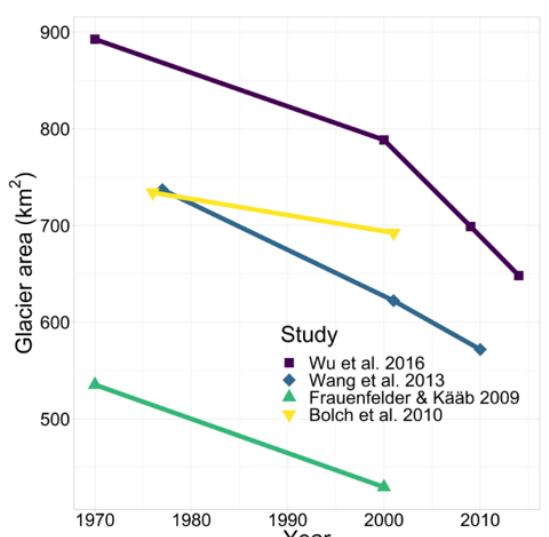
Figure 2. Glacier area reduction in the southwestern Nyainqêntan- glha range since 1970 as evaluated in various